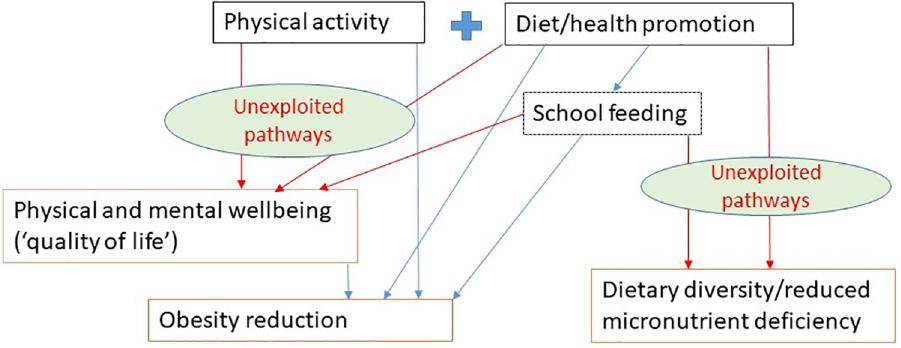
Fig 1. Conceptual framework showing unexploited